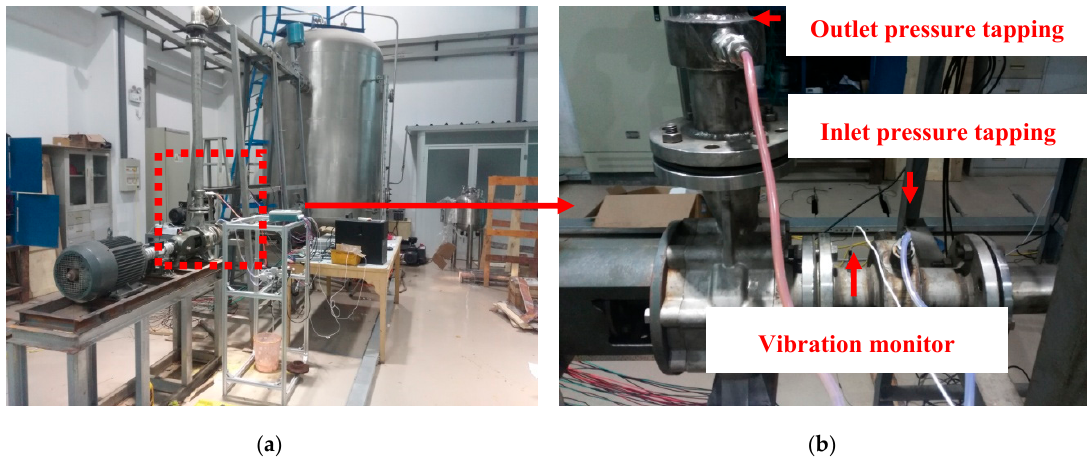
Figure 3. Instrument layout: ( a ) test site; ( b ) monitor points.